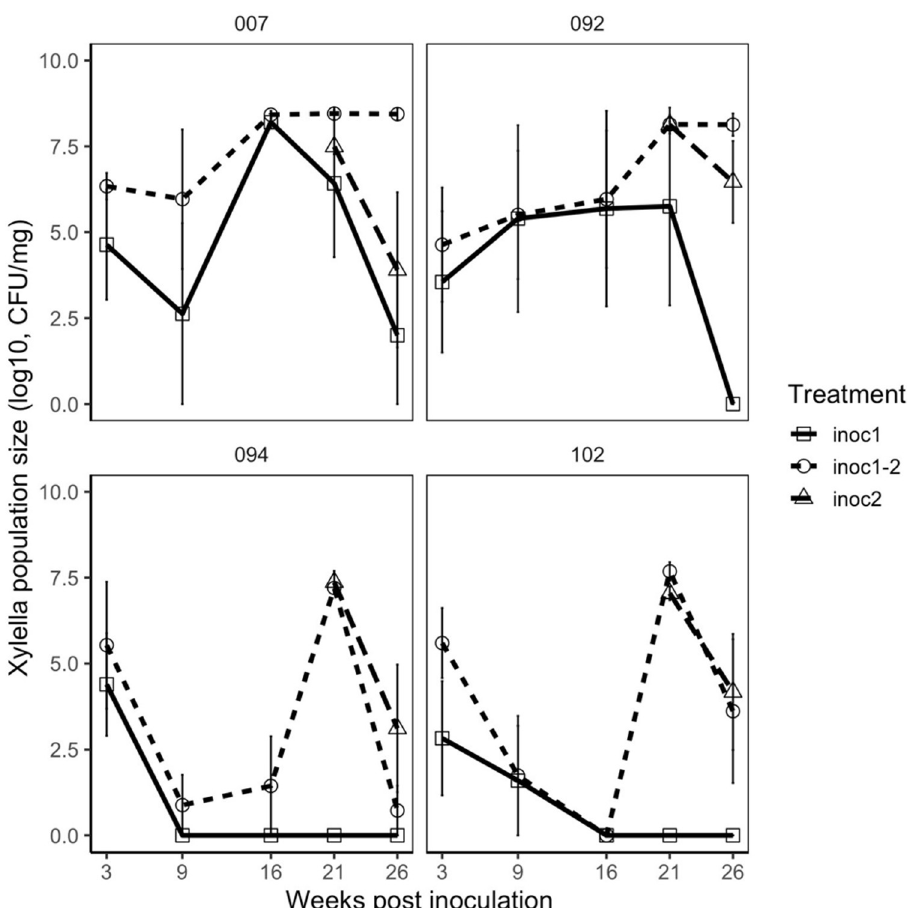
Fig 4. Xylella fastidiosa population sizes in the reinfection experiment over time. Complete timeseries for X . fastidiosa population size estimates from the reinfection experiment, measured over weeks since the first inoculation. Treatments include “inoc1” where plants were inoculated only at the first inoculation date; “inoc2” where plants were inoculated only at the second inoculation date; and “inoc1-2” where plants were inoculated at both inoculation dates. Second inoculation occurred seventeen weeks after the first inoculation. Panels represent the different genotypes used in the experiment with Susceptible genotypes on the top row (007 and 092) and Resistant genotypes on the bottom row (094 and 102).